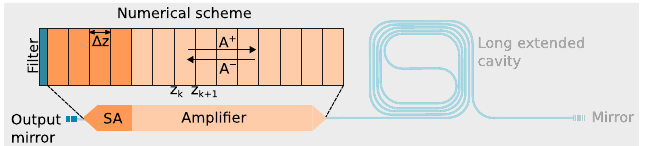
Figure 1. Traveling-wave model numerical scheme for the mode-locked laser’s active semiconductor sections. (cid:31) t . A Lorentzian filter is used at the output facet The sections are discretized in segments of optical length (cid:31) z = to model the gain bandwidth and spectral shaping of the gratings. SA saturable absorber, A ± : amplitudes of the counterpropagating waves in the